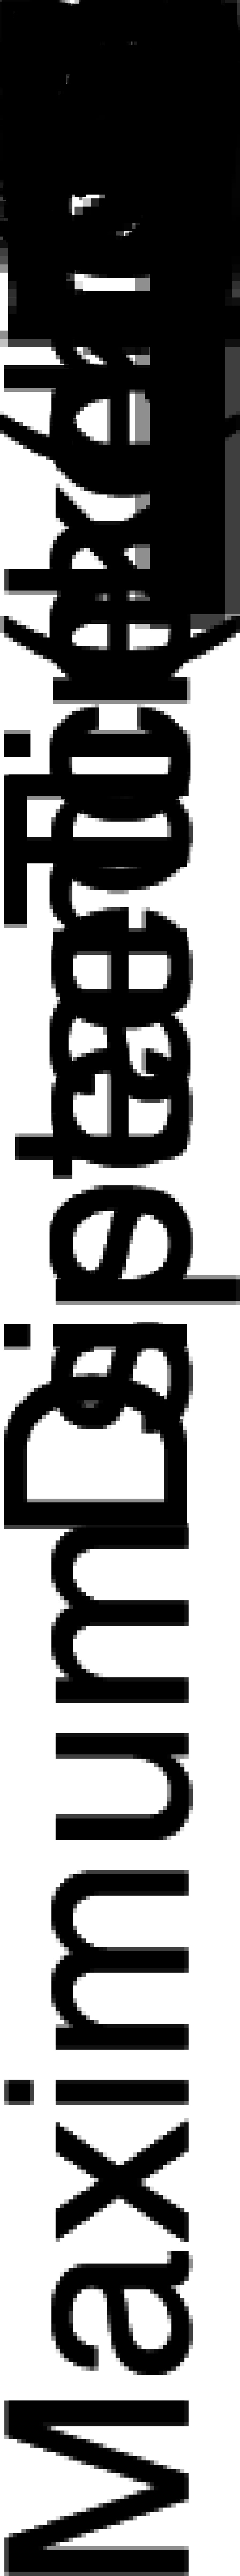
Data from the maximal effort ergometer test (a−f) at postnatal days (PND) 30 and 150. (a–c) Male offspring: control (□; n 5); overweight (■; n 8). (d–f) Female offspring: control (□; n 8); overweight (■; n 7). (a, d) Time spent (h). (b, e) Distance travelled (km). (c, f) Maximum speed developed (km/h). Values are means, with standard deviations represented by vertical bars. Data from the maximal effort ergometer tests were analysed using the unpaired t test. * P < 0⋅05 v. respective control group.